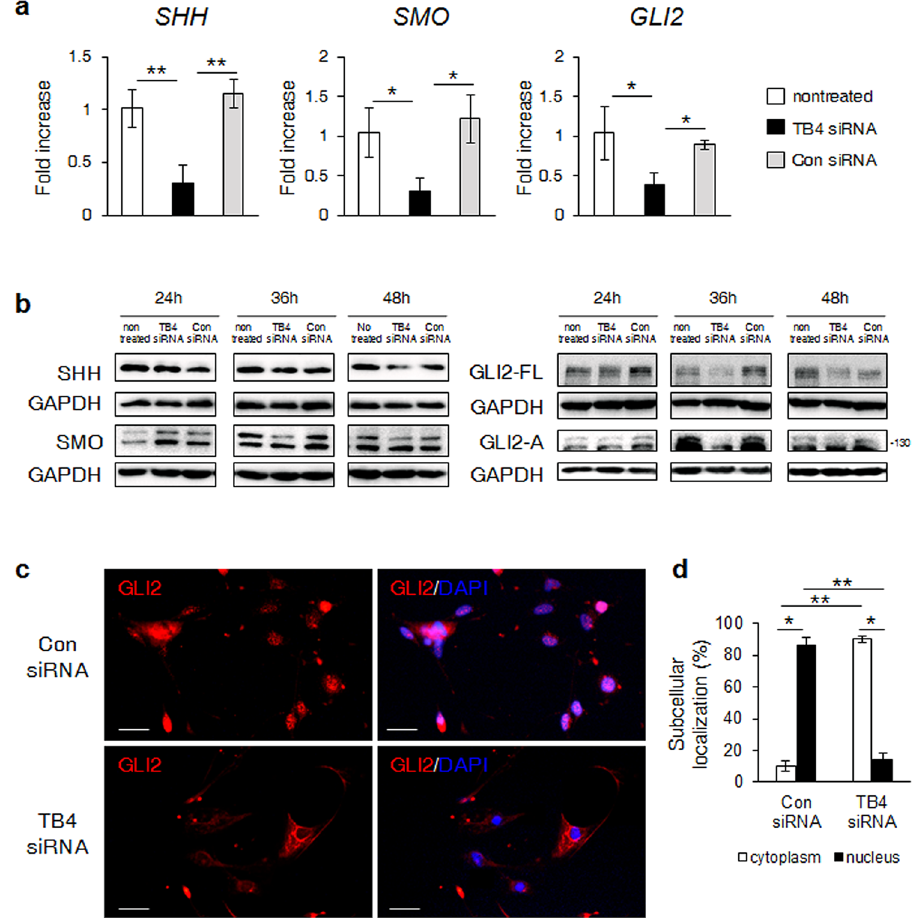
Figure 2. Knockdown of TB4 reduces expression of Hh signaling in HSCs. ( a ) RNA expression of SHH, SMO and GLI2 in nontreated or Con siRNA or TB4 siRNA-transfected LX-2 cells. LX-2 cells were transfected with TB4 or Con siRNA for 24 hours and mRNA levels were analyzed using qRT-PCR. Results of relative expression values are shown as mean ± s.e.m. of triplicate experiments ( b ) Protein expression of SHH, SMO, GLI2-full length (GLI2-FL) and GLI2-activator (GLI2-A) in these cells. Data shown represent one of three experiments with similar results and the mean ± s.e.m. results obtained from three repetitive experiments are graphed (GAPDH was used as an internal control). LX-2 cells were transfected with TB4 or Con siRNA for 24, 36, or 48 hours. Protein levels were analyzed at each time point by immunoblot against the indicated proteins. ( c ) Immunofluorescent staining for GLI2 in the LX-2 cells transfected with Con siRNA or TB4 siRNA. Representative images are shown (scale bar, 100 μ m) ( × 20). ( d ) Quantification of subcellular localization of GLI2 in these cells. The percentage of GLI2-positive cells in nucleus or cytoplasm is shown. ( * p < 0.05; ** p <